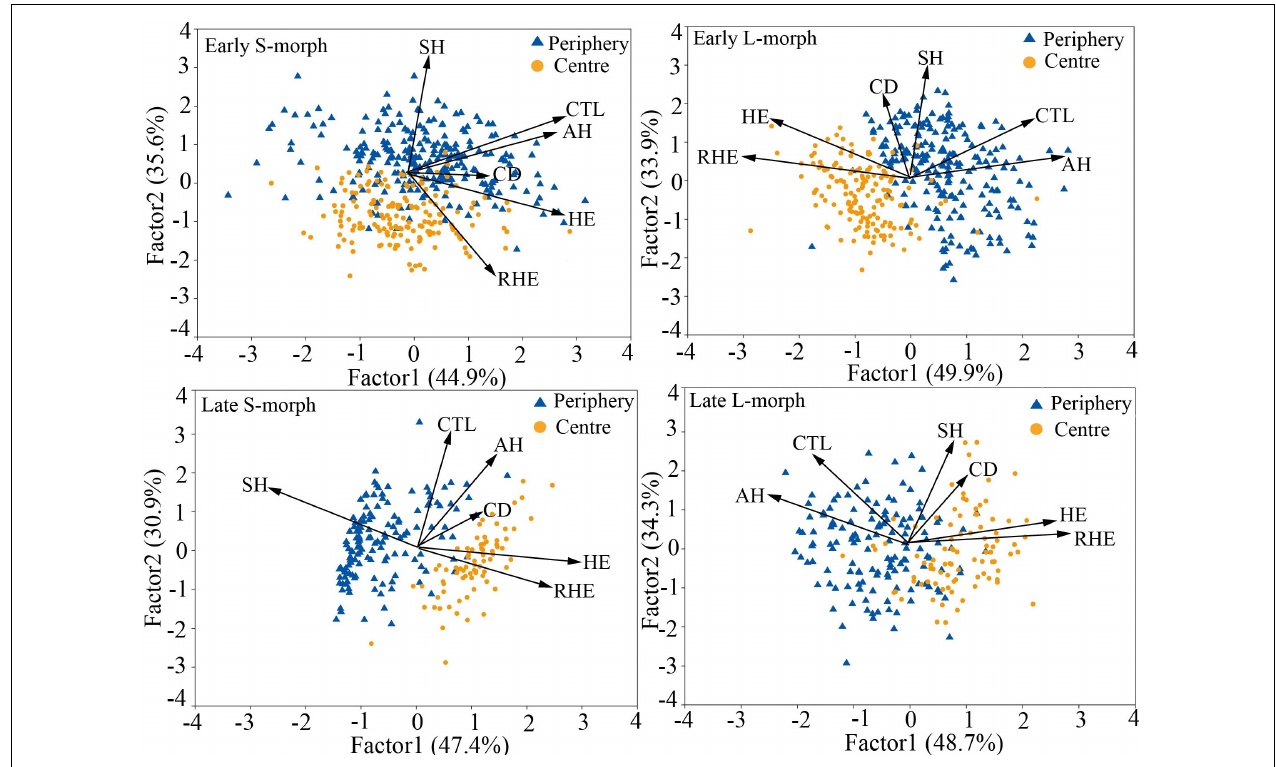
FIGURE 1 | Principal component analysis (PCA) biplots of six floral traits of L-morph and S-morph individuals of Primula wannanensis in central and peripheral populations at different florescence stages. SH, stigma height; AH, anther height; CTL, corolla tube length; HE, herkogamy; RHE, relative herkogamy; CD, corolla